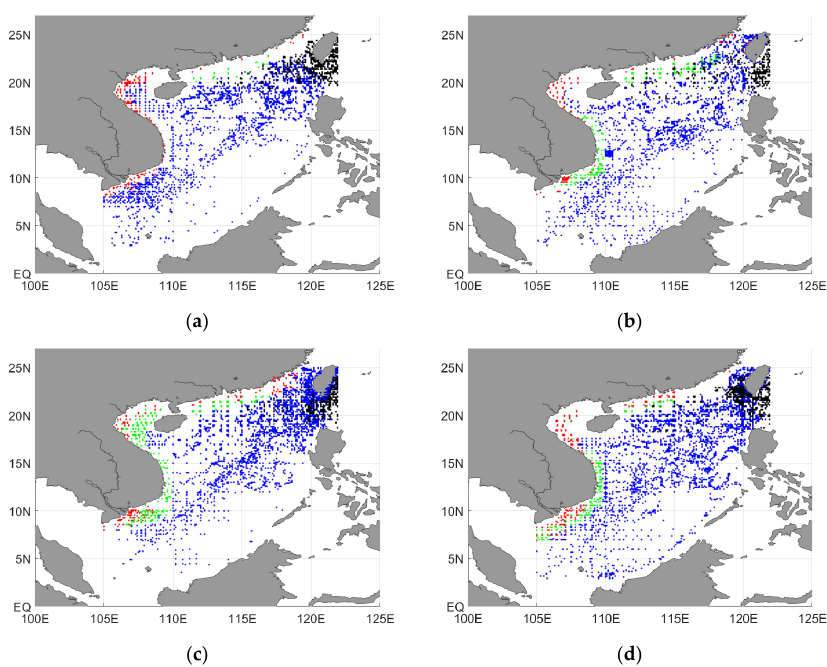
Figure 3 . Surface water mass division. ( a ) Winter, ( b ) spring, ( c ) summer, and ( d ) autumn. Red scatter: the coastal diluted water (F); green scatter: the nearshore mixed water (M); blue scatter: the SCS surface water (S) and the southern SCS shelf water (SS) (which only occurs in summer); black scatter: the Kuroshio surface water (KS). J. Mar. Sci. Eng. 2023 , 11 , x FOR PEER REVIEW